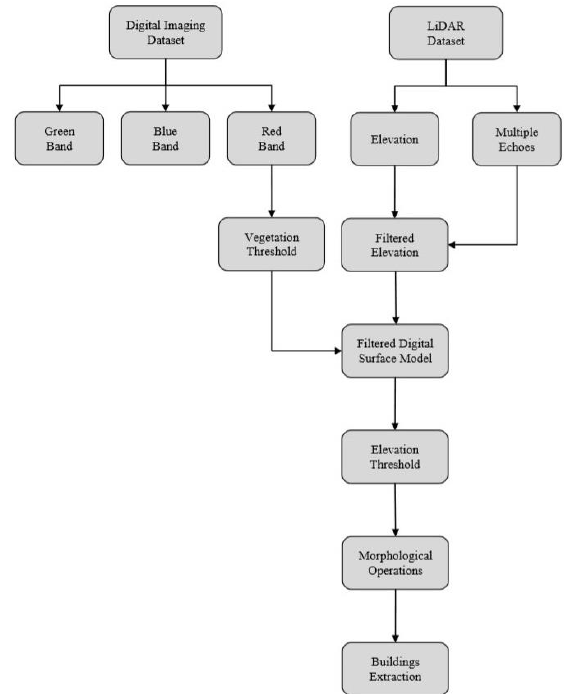
Figure 1. The threshold-based automated buildings extraction